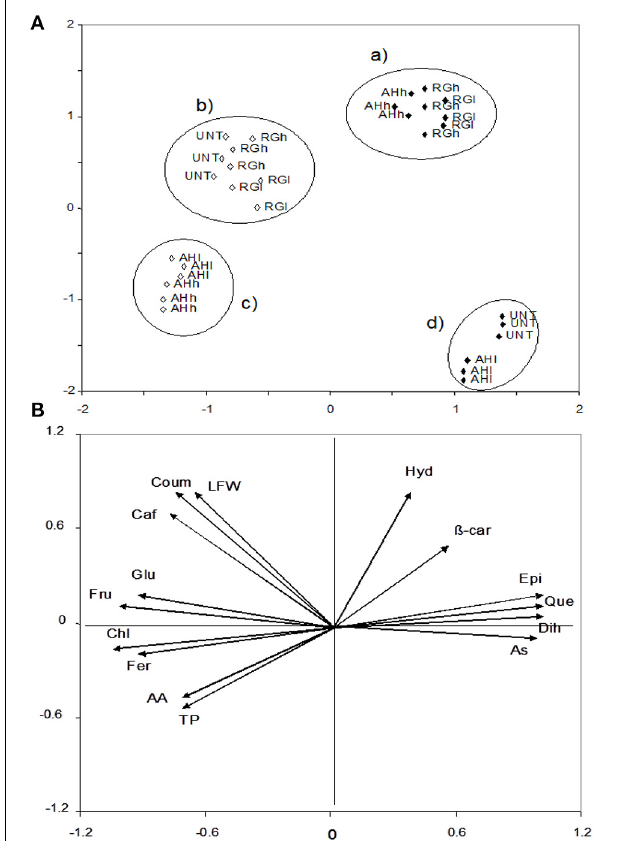
FIGURE 3 | PCA leaves scatterplot of the plants treated with and without biostimulants (upper, A) and position of the variables projected in the plane as determined by the first two principal axes (lower, B) (85% explained variance). Alfalfa hydrolyzed (AH) and red grape (RG) biostimulants applied at low (l) and high (h) doses, whereas no application was performed on the control (untreated, UNT). Black and white diamonds correspond to the leaves chemical composition after the 1st and 2nd application. AA, antioxidant activity; As, ascorbic acid; β -car, β -carotene; Caf, caffeic acid; Chl, chlorogenic acid; Coum, p -coumaric acid; Epi, epicatechic acid; Fer, ferulic acid; Fru, fructose; Glu, glucose; Hyd, p -hydroxybenzoic acid; LFW, leaves fresh weight; Que, quercetin; and TP, total phenols.